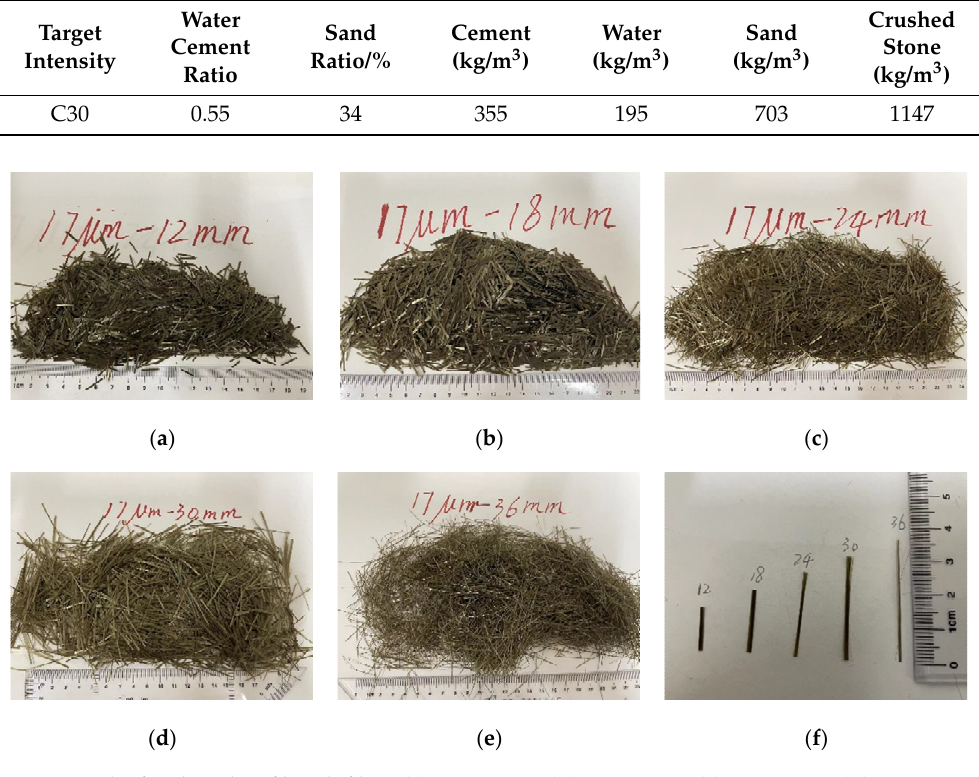
Table 1. The mixed proportion of the concrete.